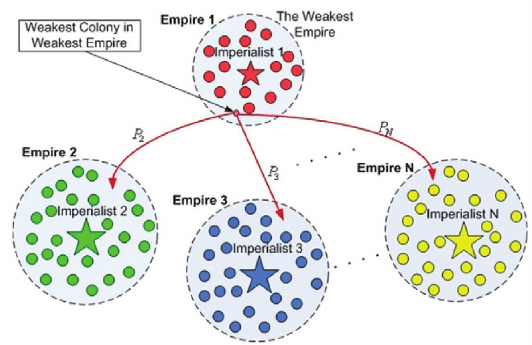
Figure 7. Imperialistic competition. The more powerful an empire has more probability to possess the weakest colony of the weakest